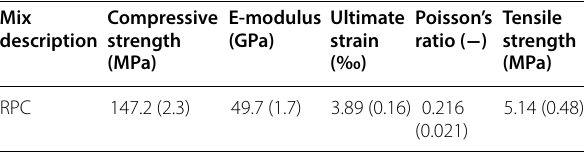
Table 1 Summary of mechanical strength properties (28 days) for RPC, given as mean values and standard deviations in parenthesis. Source: (Mueller et al. 2016).